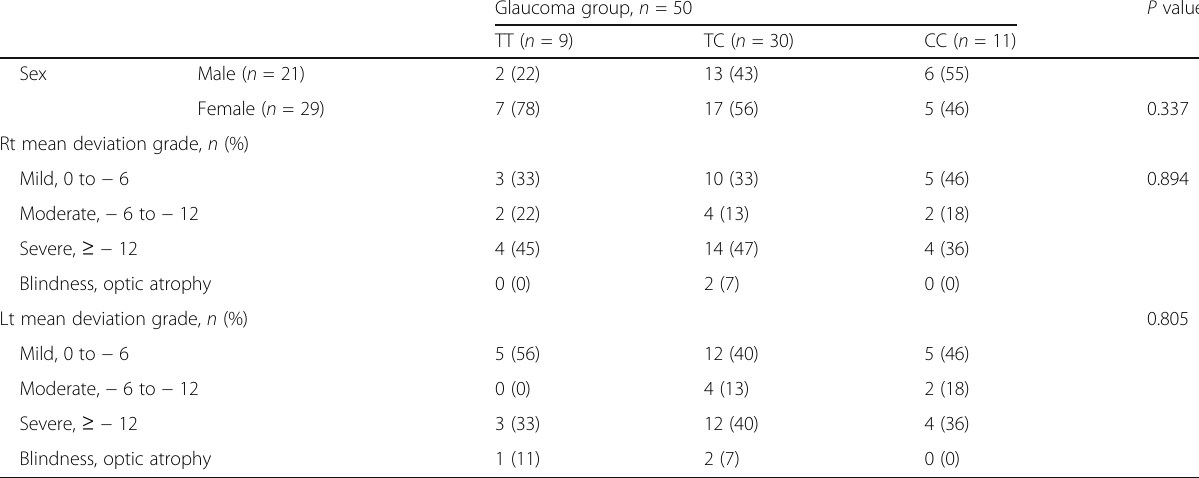
Table 2 Association between sex, MD of visual field with grades, and BDNF genotypes frequency in glaucoma group